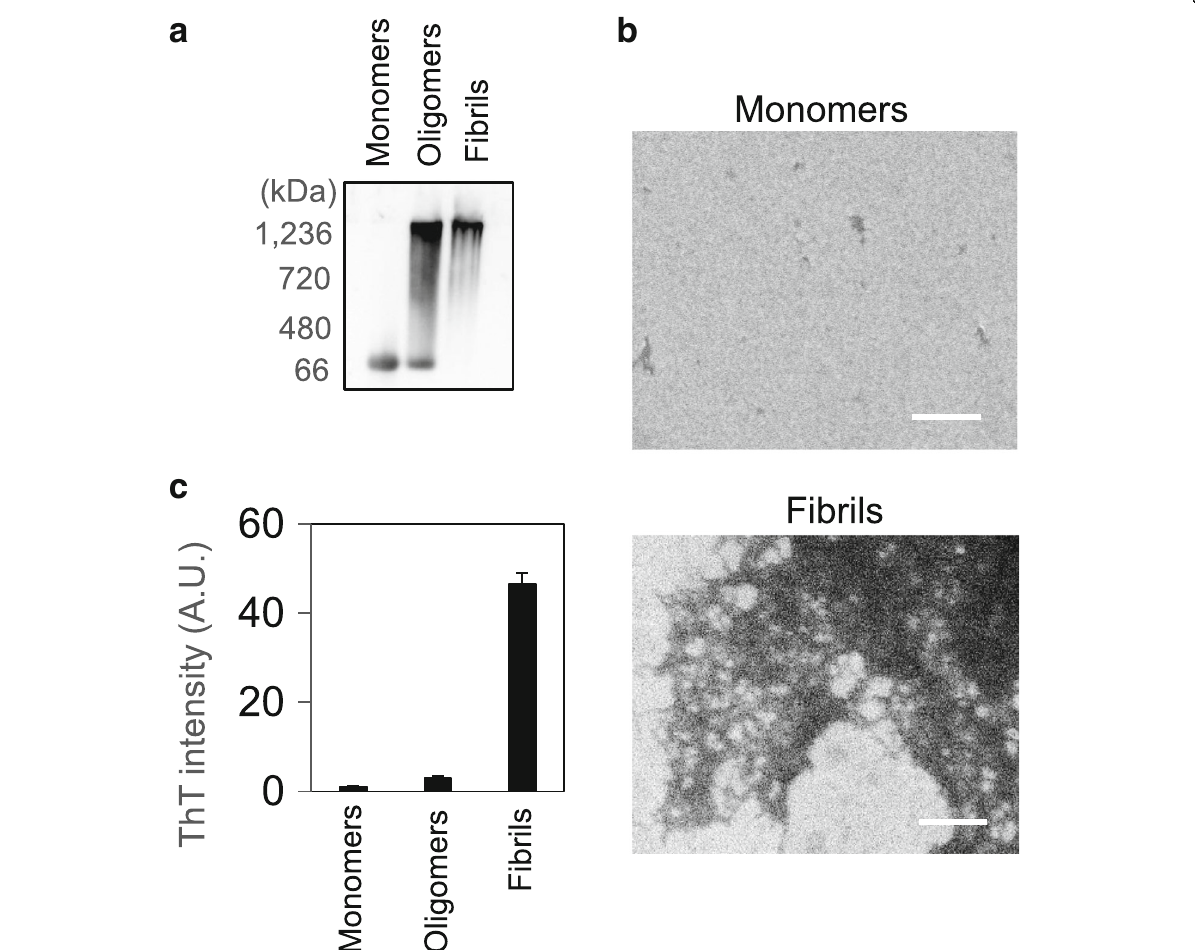
Fig. 1 A β 42 oligomerization and morphological changes. a A β 42 oligomerization sequences. A β 42 monomers (45 μ M) were incubated under oligomerization conditions at room temperature for 0 h (monomers) or for 14 h (oligomers), or at 37 °C for 48 h (fibrils), and applied to 8% native polyacrylamide gel electrophoresis followed by Western blotting. b The ThT assay revealed A β 42 assembly under oligomerization conditions at room temperature for 0 h (monomers) or 14 h (oligomers), or at 37 °C for 48 h (fibrils). c Morphological images of A β 42 samples under oligomerization conditions for 0 h at room temperature (monomers) or for 48 h at 37 °C (fibrils). Scale bars are 500